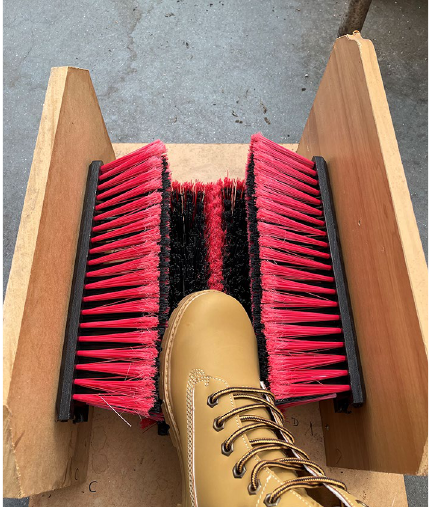
Figure 3. Fixed boot brush device, constructed from broom heads bolted onto timber sheets, used in the